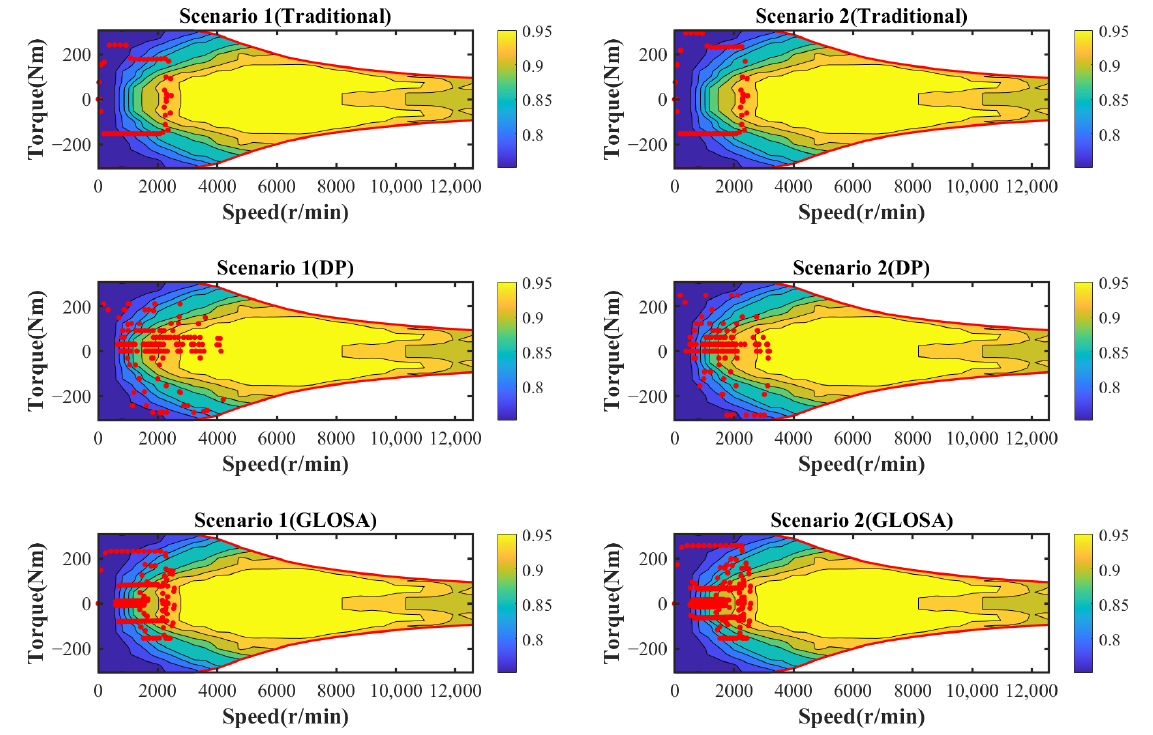
Figure 9. Motor operating point distribution diagram.